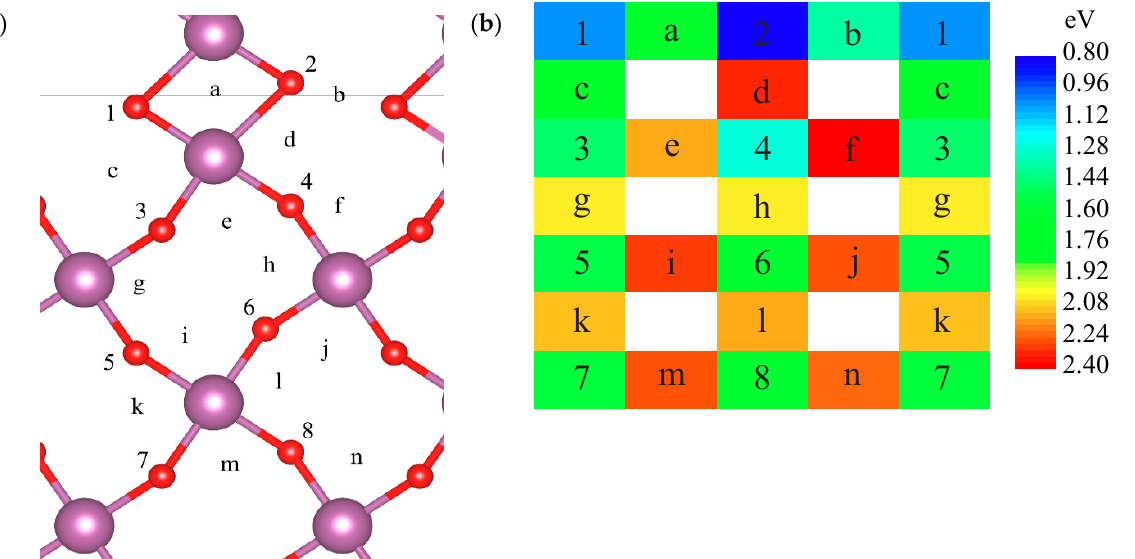
Figure 3. Oxygen vacancy formation energy (numbers) and transition states (letters) within the (100) edge-shared (Figure 1c) interface (solid horizontal line) and in the bulk. ( a ) Indexed crystal structure, (010) plane, and ( b ) schematic view with coloured energy states, relative to the ideal interface and 1/2O 2 (Equation (2)). Table 5. Oxygen vacancy formation (Equation (2)) and activation (Equation (3)) energy, as in Figure 3.